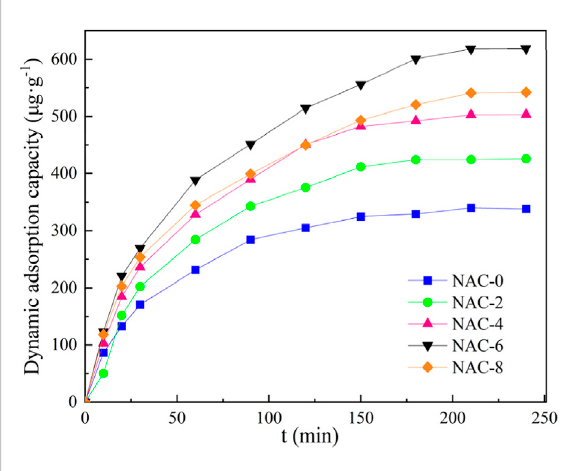
FIGURE 5 Total acidic groups of the NAC-x samples.